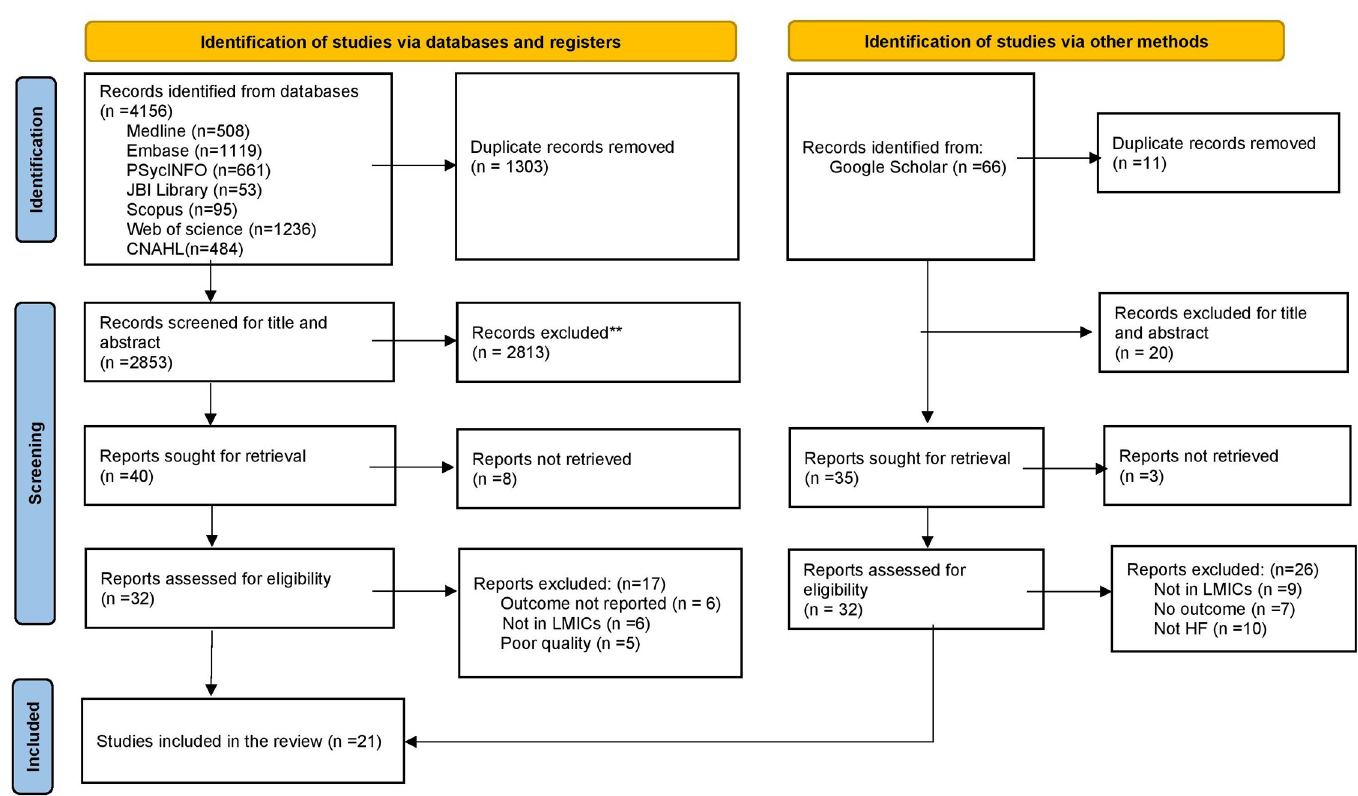
Fig 1. PRISMA flow diagram of literature identification, study selection and inclusion process.